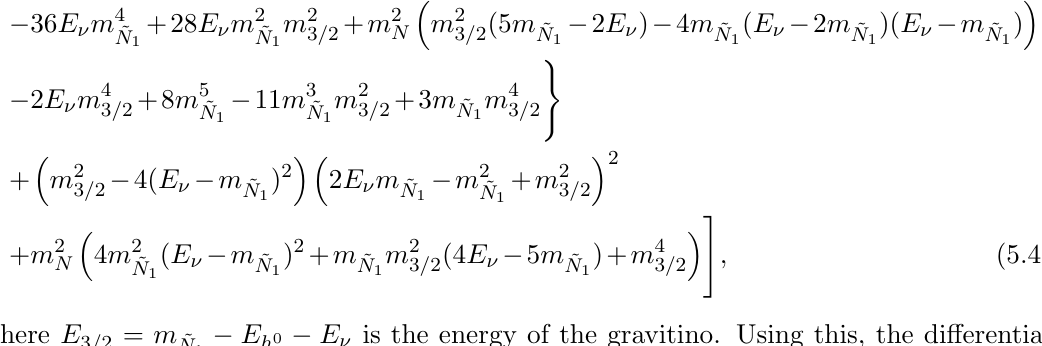
Figure 3 . Neutrino source spectra from RH sneutrino decay through the process ~ N 1 ! with m ~ = 6 : 5 PeV, m N = 8 PeV and m = 1 : 5 PeV. The dashed blue line shows the neutrino 3 = 2 N 1 spectrum obtained from the primary neutrinos produced directly from the decay of the RH sneu- trino. The red dashed line shows the neutrino spectrum obtained from the decay of the Higgs into neutrinos. Finally, the dashed black line represents the total neutrino spectrum obtained from the three-body decay of the